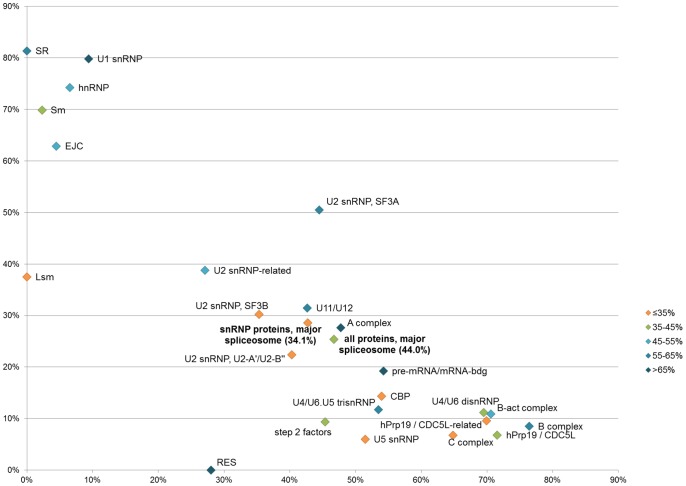
Types of disorder in core spliceosomal proteins.Compositionally biased disorder (Y-axis) vs. disorder with SS (X-axis). Datapoints are colored according to predicted total per-residue disorder content. Groups of all proteins of the major spliceosome and all proteins of the snRNP subunits of the major spliceosome are indicated in bold.